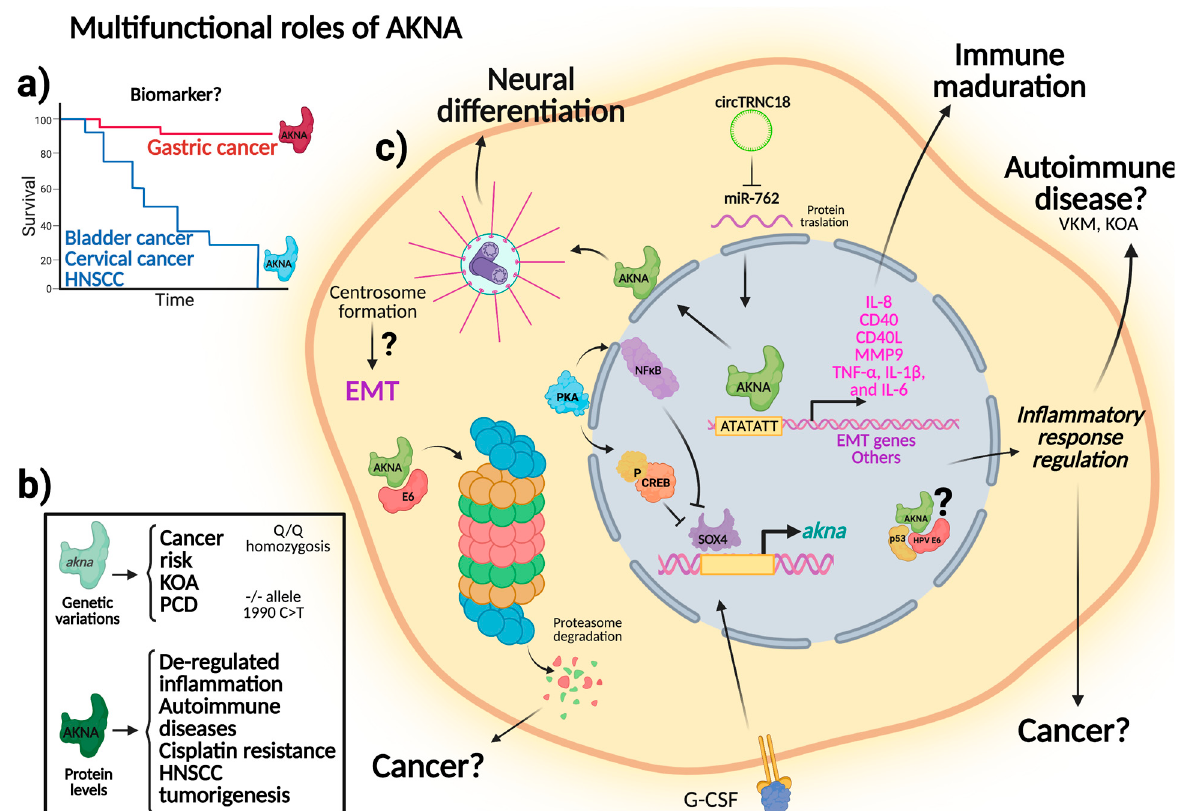
Figure 2. Multifunctional roles of AKNA. The impact of either protein levels or variations on the encoding AKNA gene have been studied in different models. A summary of the known activities of AKNA is depicted. ( a ) AKNA expression levels have been proposed as potential prognostic factors in different types of cancer; ( b ) variations in the AKNA sequence are associated to an increased risk for developing cancer, KOA, PCD. AKNA protein levels are involved in immune de-regulation, autoimmune diseases, cisplatin resistance, and HNSCC tumorigenesis; ( c ) molecular functions of AKNA are involved in the regulation of the inflammatory phenotype due to the ability of AKNA to promote cytokine gene expression, which in turn produces an aberrant immune regulation. AKNA has also been associated with cancer development, neural differentiation, and autoimmune disease, but the precise mechanisms underlying these processes remain unknown. The potential implications of AKNA in different cellular processes are indicated. HNSCC: head and neck squamous cell carcinoma; KOA: knee osteoarthritis; PCD: primary ciliary dyskinesia.